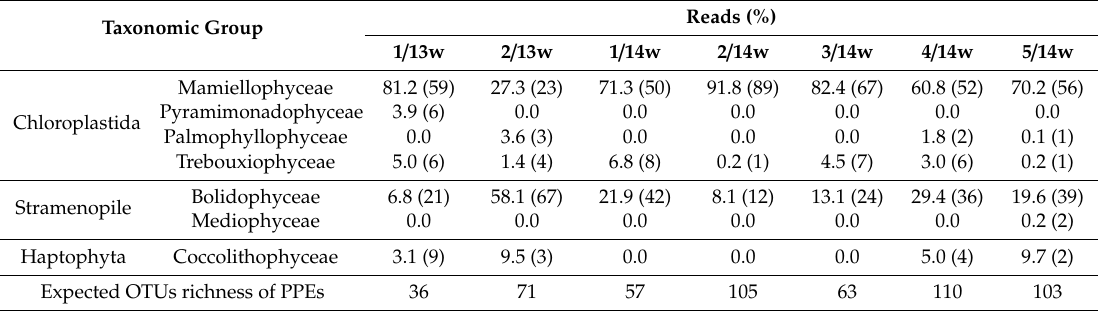
Table 3. Relative abundance (%) of PPE groups based on V4 rDNA reads and the expected OTUs indicated in